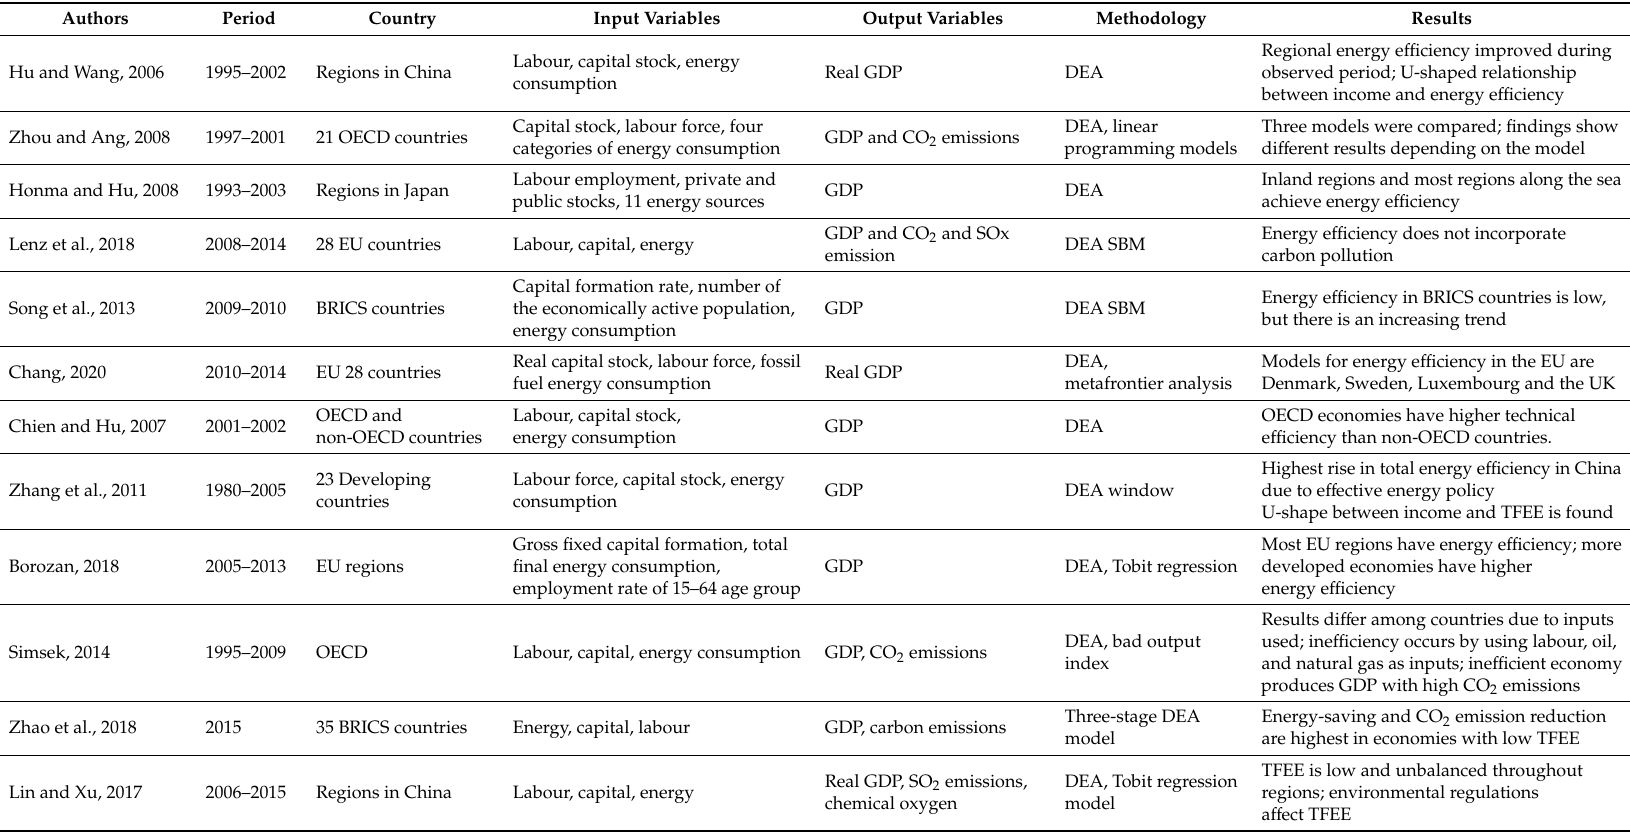
Table A1. Relevant literature on TFEE, the relationship between energy e ffi ciency and economic and financial development. DEA: data envelopment analysis; SBM: slacks-based